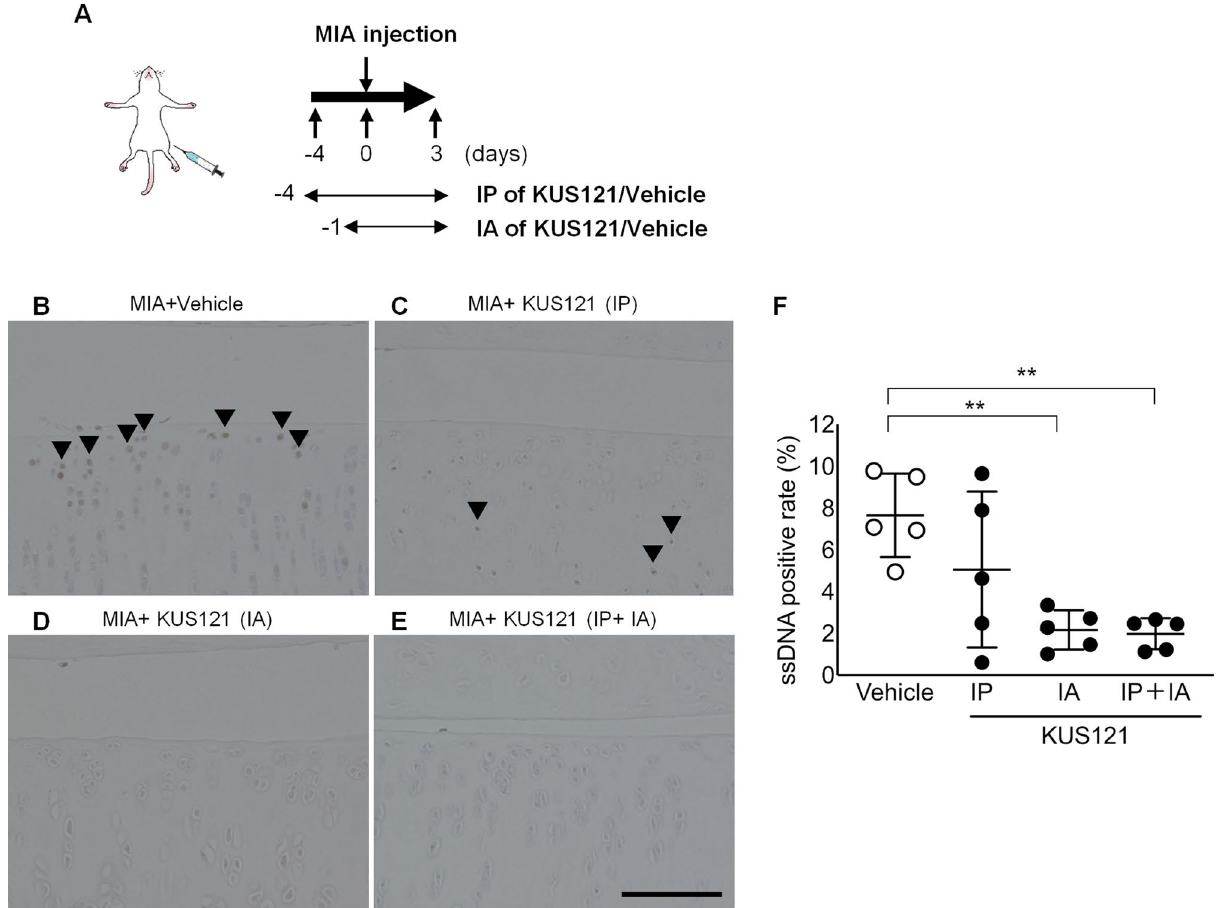
Figure 4. Administration of KUS121 reduces chondrocyte apoptosis in rats. ( A ) Monosodium iodoacetate (MIA, 0.5 mg) was intra-articularly injected into the knee joint of rats. KUS121 was administered intraperitoneally (IP, 50 mg/kg/day), intra-articularly (IA, 500 µg/day), or both. ( B – E ) Knee joints treated with either KUS121 or vehicle were stained with an anti-ssDNA antibody. Scale bar, 100 µm. Black triangles indicate ssDNA-positive apoptotic chondrocytes. ( F ) The ssDNA-positivity was calculated as the number of ssDNA- positive cells divided by the total number of chondrocytes above the Tidemark. Independent data points for ssDNA-positivity with mean ± standard deviation are shown. **p < 0.01, vs MIA without KUS121, Dunnett T3 test, N =